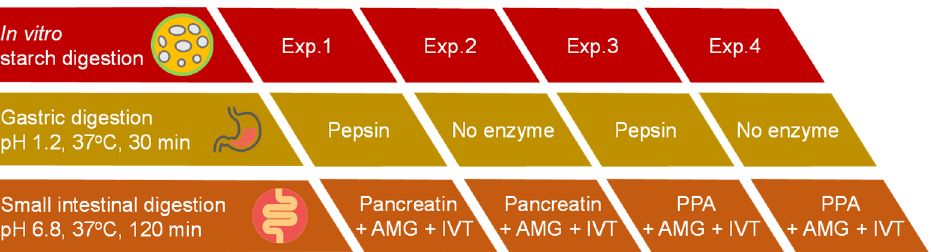
Figure 1. Schematic diagram of four different experiments for evaluating the indirect effect of proteolytic enzymes on in vitro starch digestion of cooked samples of control isolated navy bean cotyledon cells (INC-Control). Abbreviations: AMG—amyloglucosidase, IVT—invertase, PPA—porcine pancreatic α -amylase.